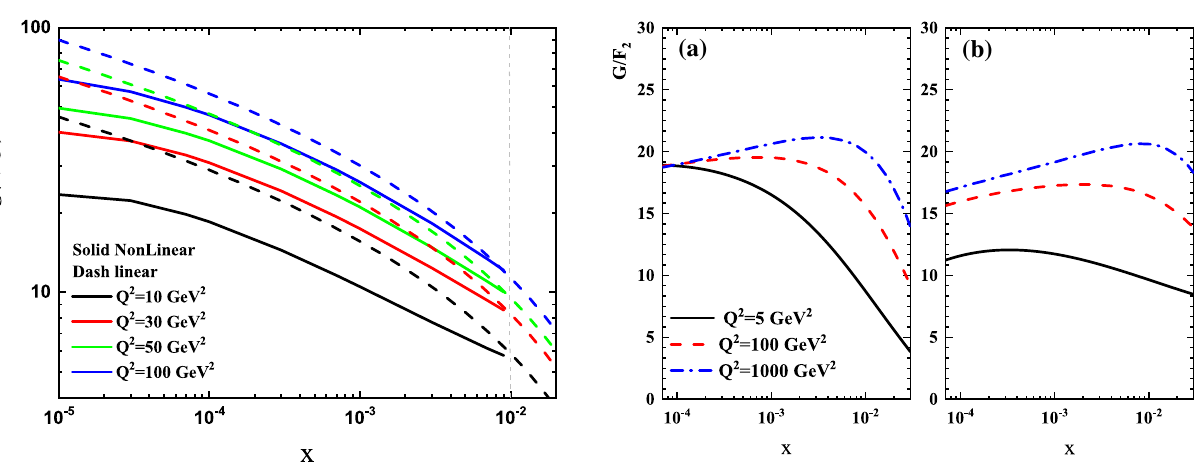
= 0 and 1 GeV 2 [25] 0